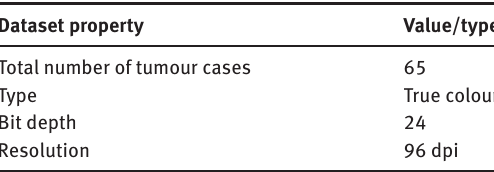
Table 1: Characteristics of MRI Brain Image BRATS